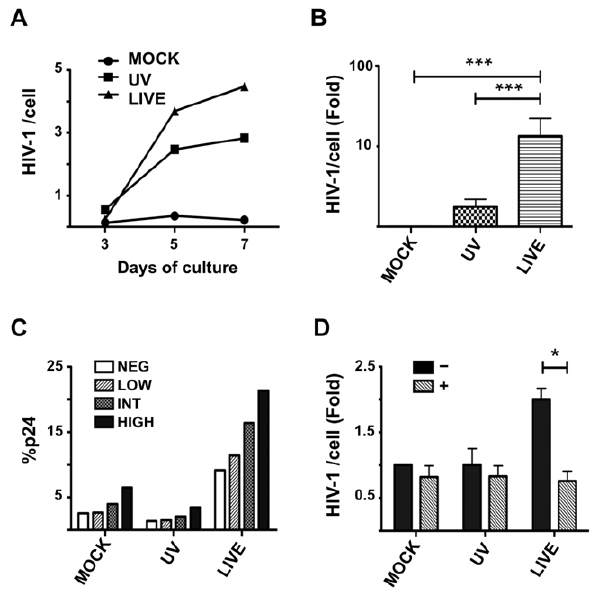
Figure 6. HSV-2 infection enhances HIV-1 replication in a RA- dependent manner. Mock-, UV-HSV-2-, or Live HSV-2-treated DCs were loaded with HIV-1 and co-cultured with autologous CD4 + T cells for 3 to 7 days (A) or 5 days (B–E). A) The kinetics of infection is shown for 1 of 3 similar experiments. B) The fold changes (mean 6 SEM of 15 independent experiments) in HIV-1 DNA copies/cell for the 3 conditions after 5 days of co-culture are shown relative to the MOCK controls (set as 1). C) The percentage of p24 + CD4 + T cells within each a 4 b 7 subset was measured 5 days after co-culture with the differently treated DCs. 1 of 3 independent experiments is shown. D) The fold changes (mean 6 SEM, 4 independent experiments) in the HIV-1 copies/cell in presence ( + ) or absence ( 2 ) of the RAR a antagonist are shown relative to the mock-treated controls (set as 1). One experiment, in which the HIV-1 infection was about 100 fold higher in the live HSV-2 condition compared to the mock treated, was excluded. In the excluded experiment the RAR a antagonist did not reverse the HSV-2-infected DC enhancement effect (reduced by 20%). (*p , 0.05, ** , 0.01, ***p #